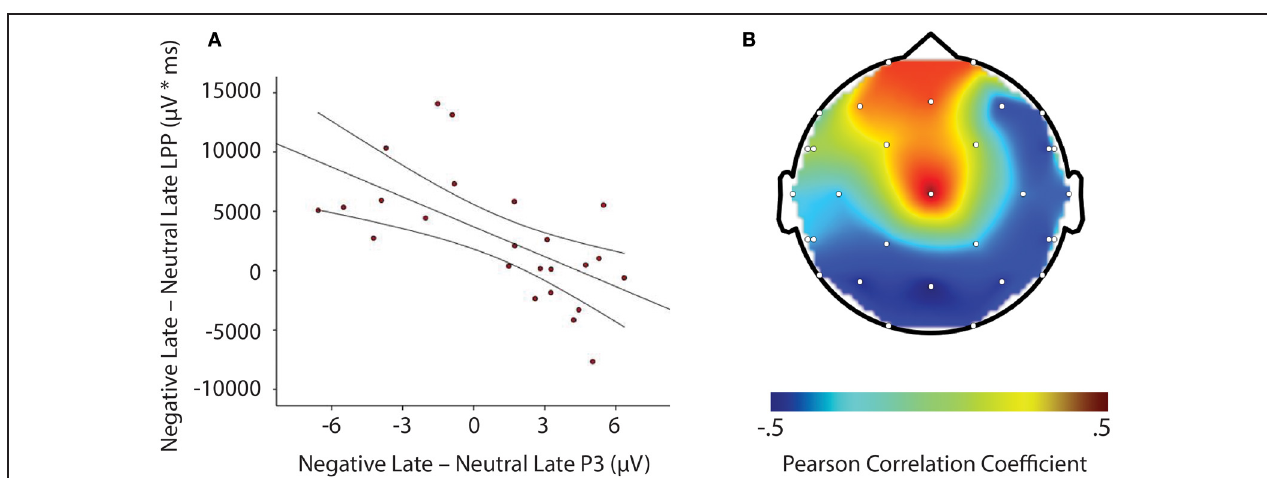
FIGURE 4 | Illustration depicting: (A) Voltage difference map for the P3 component (350ms) when faces followed negative images, relative to neutral. (B) Voltage difference map for the P3 component (350ms) when positive images preceded faces, relative to neutral images. (C) Grand-averaged ERP waveforms of subjects during face-targets in each